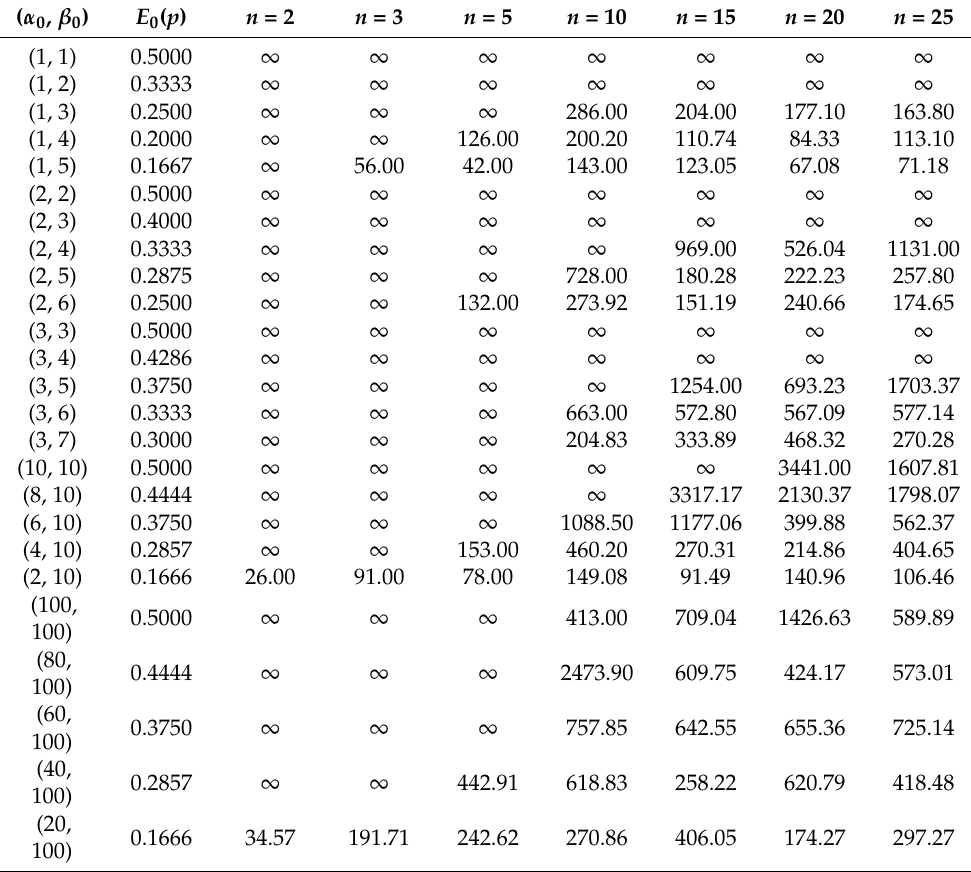
Table 1. The in-control average run lengths ( ARL 0 s) of the proposed Bayesian variance